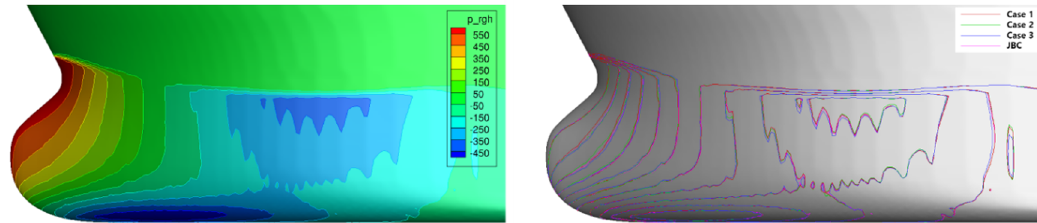
Figure 12. Comparison of pressure distributions around the bow ( left : JBC only, right : JBC and deformed hull).